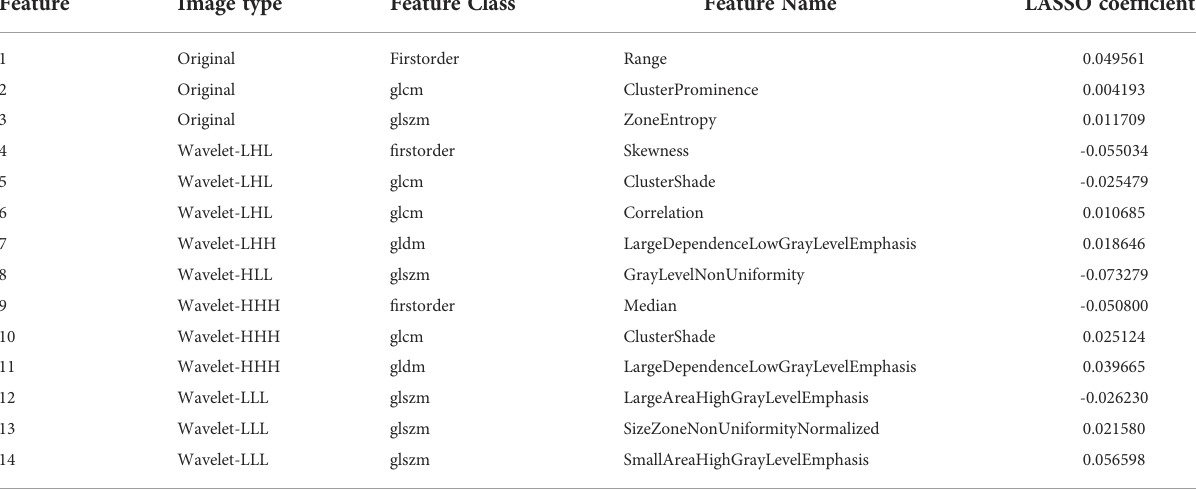
TABLE 2 The subset of radiomics features ultimately selected by the LASSO